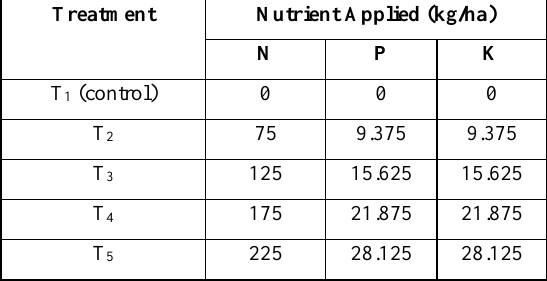
Table 1. NPK Concentrations per Treatment